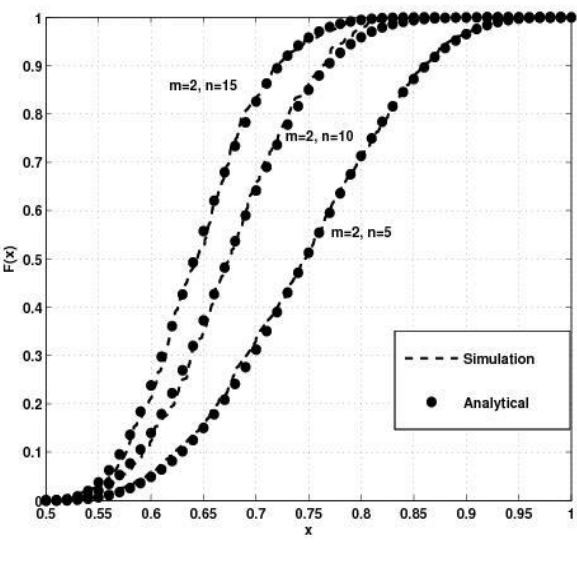
Figure 8. The CDF of the ratio of the largest eigenvalue to the trace of a uncorrelated dual complex Wishart